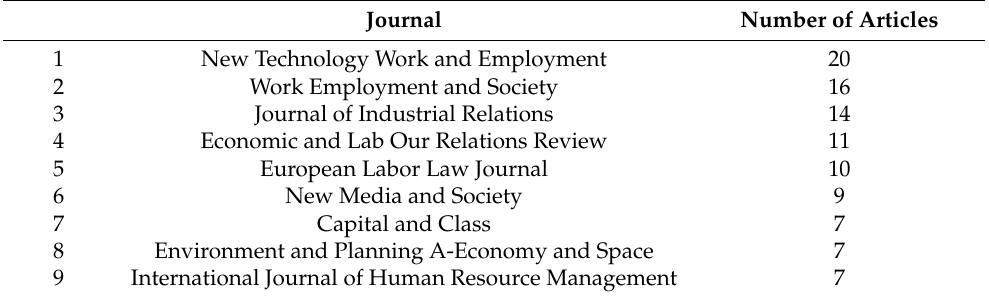
Table 4. The most relevant sources according to the publication number. Source: RStudio